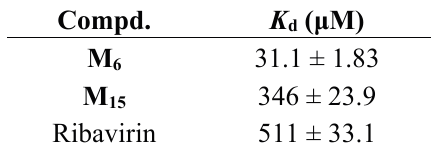
( A ); M ( B ); and Ribavirin ( C ). 6 15 , M , and Ribavirin with TMV- coat protein 6 15